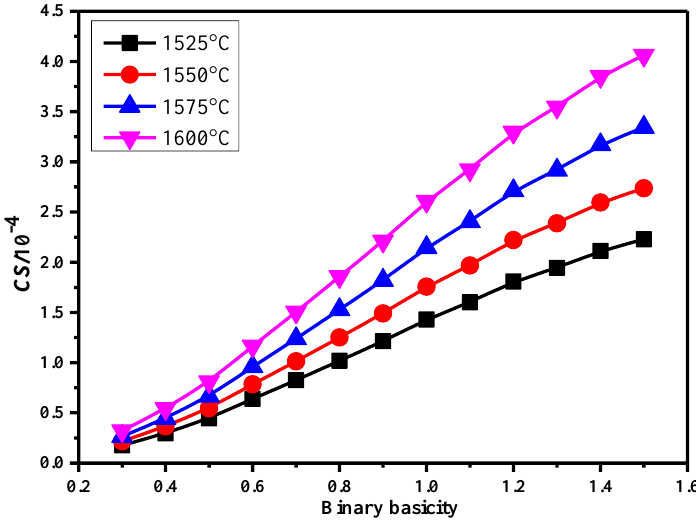
ff ect of basicity and temperature on CS of the Figure 10. Effect of basicity and temperature on CS of the slag. Figure 10. E